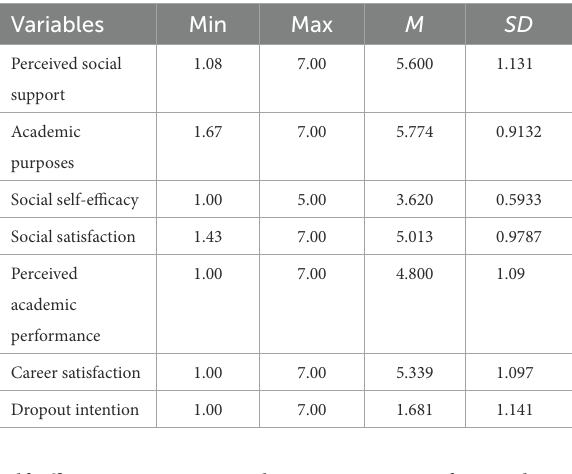
TABLE 2 Descriptive statistics of the scores of the